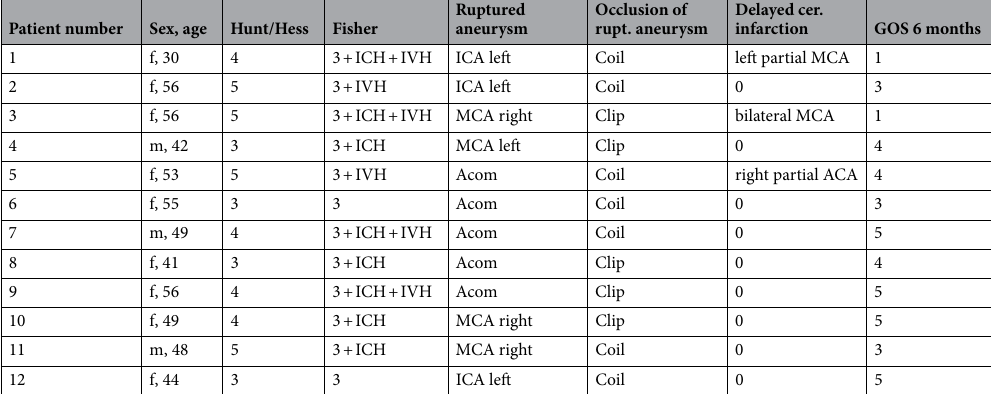
Table 1. Personal, hemorrhage-related and aneurysm-related characteristics of 12 study patients. Two patients developed minor secondary infarction (one partial left MCA and one partial right ACA territory). One patient with primary large right temporal ICH developed territorial infarctions in both MCA territories in the course of treatment. Two patients died, one from rebleeding from an endovascularly occluded aneurysm outside of study procedures and one due to extended infarction in both MCA territories. ICH intracerebral hemorrhage, IVH intraventricular hemorrhage, ICA internal carotid artery, MCA middle cerebral artery, Acom anterior communicating artery, GOS Glasgow Outcome